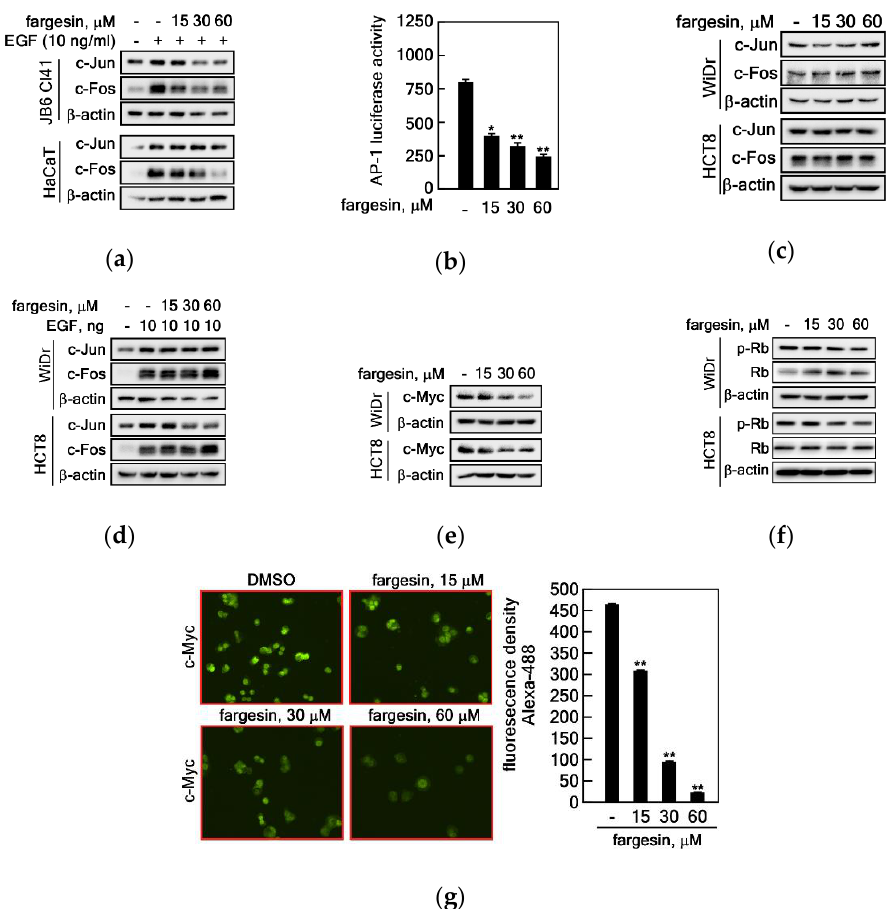
Figure 5. Differential regulation of AP-1 signaling and c-Myc-mediated CDK2/cyclin E signaling mediates cell proliferation differentially in premalignant and cancer cells. ( a ) Fargesin suppresses EGF-induced c-Jun and c-Fos protein levels in JB6 Cl41 and HaCaT cells. Cell lysates (30 μg) ex- tracted from JB6 Cl41 and HaCaT cells were utilized to examine the protein levels of c-Jun and c- Fos by Western blotting using specific antibodies as indicated. ( b ) Fargesin inhibits AP-1 transacti- vation activity. JB6 Cl41 (5 × 10 4 ) cells stably transfected with AP-1 luciferase reporter plasmid were subjected to AP-1 transactivation activity analysis as described in “Materials and Methods”.